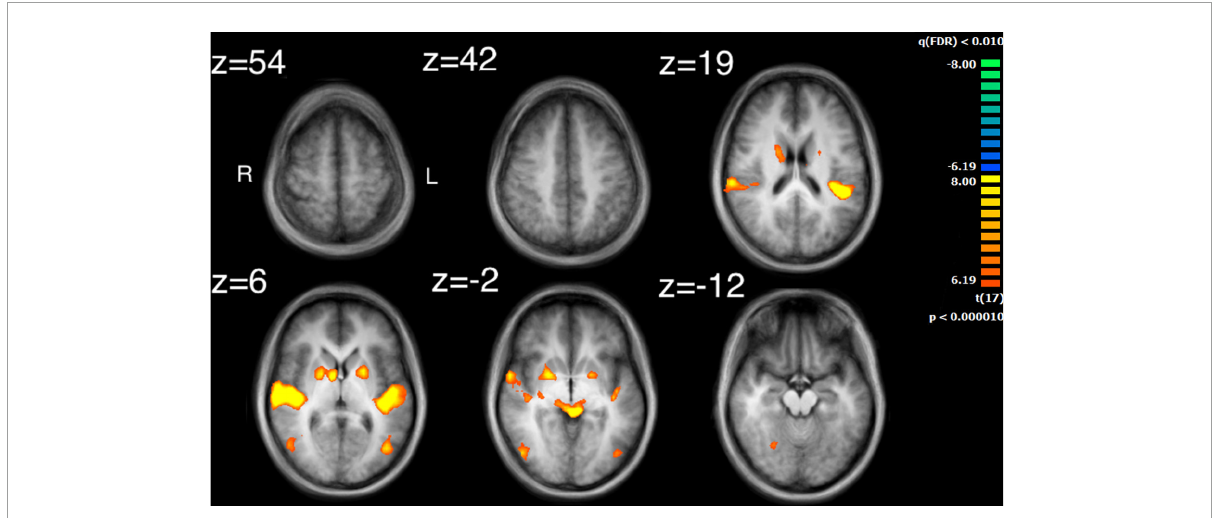
FIGURE5 Activation for the median values of speed. Significant regions of activity include the bilateral posterior insula extending into superior temporal gyrus as well as right inferior temporal and left middle occipital gyrus in addition to numerous subcortical structures.